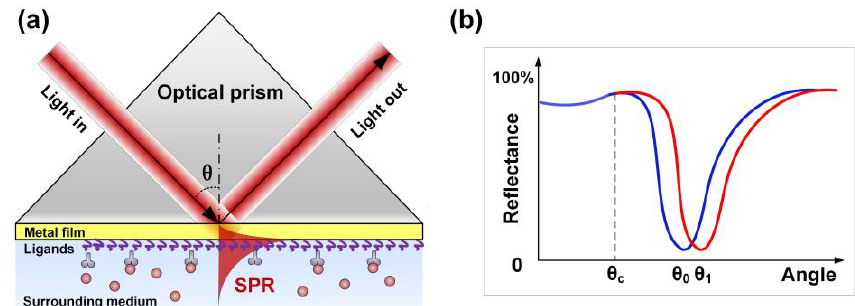
Figure 1. ( a ) Sketch of the Kretschmann prism configuration used for plasmonic sensing; and ( b ) its response to surrounding refractive index changes linked to biomolecules binding.